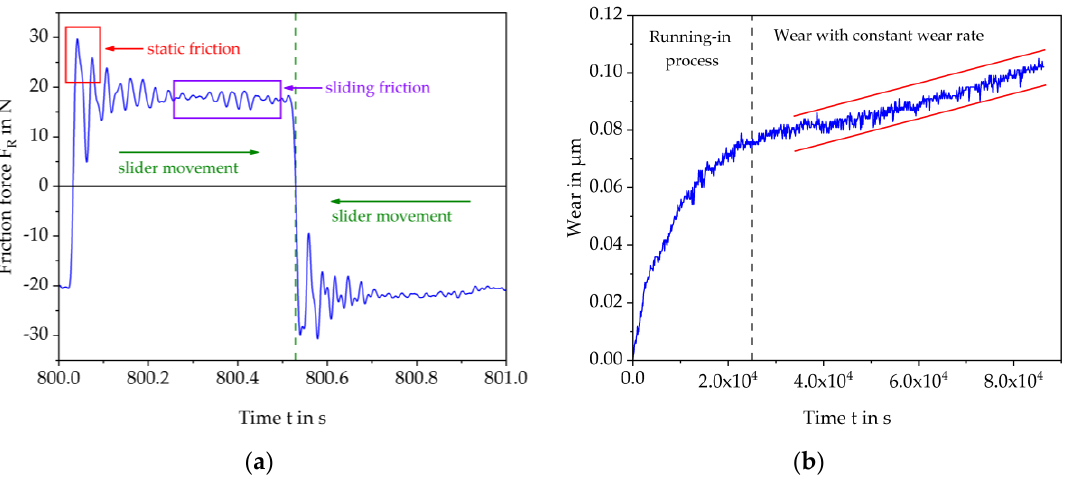
Figure 5. Exemplary illustration of the raw data of the tribo-tester measurement acquisition system: ( a ) Friction force during the foreward and backward movement of the slide within one test cycle; ( b ) Wear measurement based on the test specimen height for a test duration of 24 h.